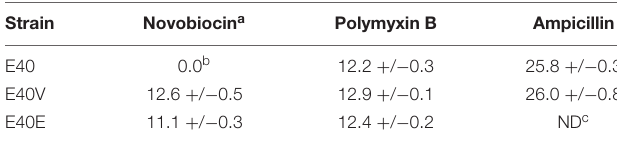
TABLE 3 | Zones of inhibition of S. enterica strains E40, E40V and E40E with the following antibiotics: novobiocin (1.5 µ g/disc), polymyxin B (3 µ g/disc), and ampicillin (10 µ